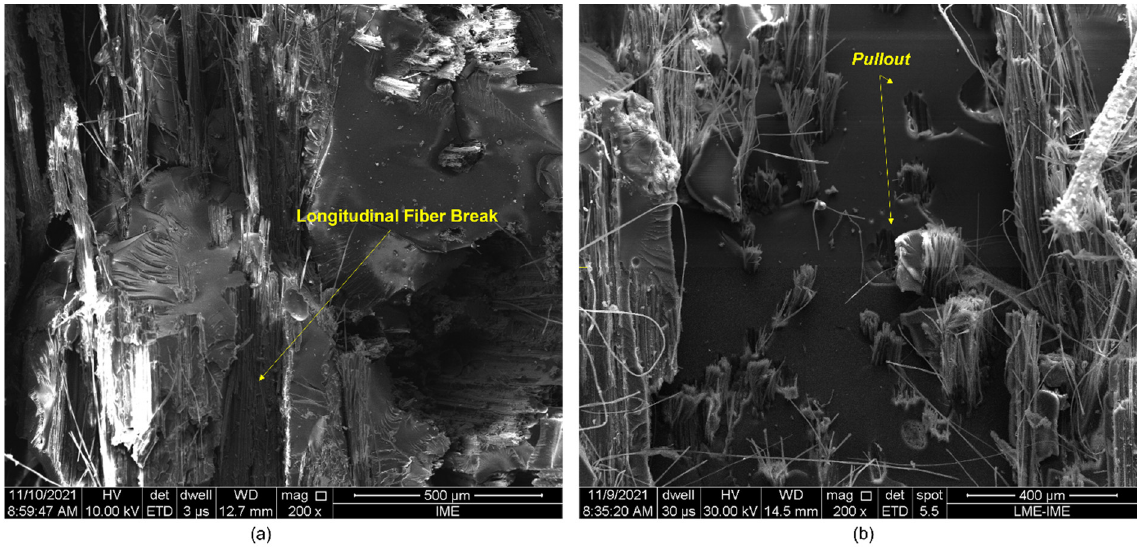
Figure 7. Fracture surface of a composite with 20 vol.% of fibers (PNT/ENT) arranged: unidirection- ally ( a ) and bidirectionally ( b ), at 200× magnification.